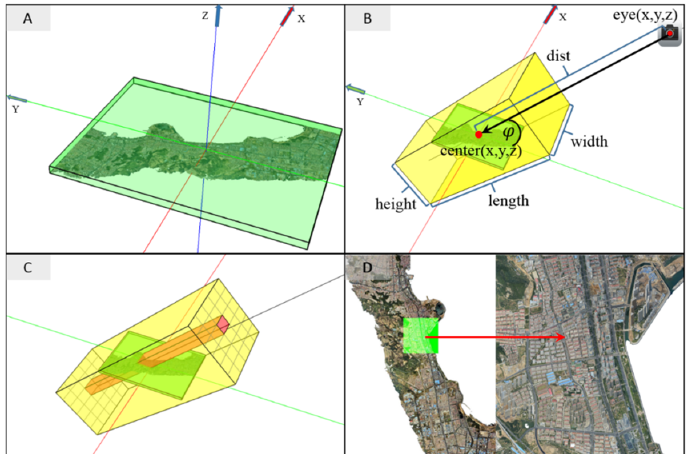
Figure 5. Constructing an oblique camera ( (cid:2016) = 0°, (cid:2030) = 45°) for rendering 2.5D maps: ( A ) bounding box of the 3D city models; ( B ) camera configuration; ( C ) spatial partitioning; and ( D ) a map tile rendered from a sub-camera.